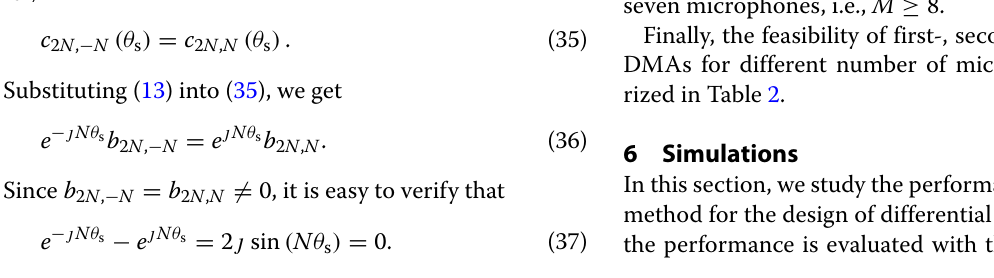
Table 2 Feasibility of the first-, second-, and third-order DMAs for different number of microphones, where “ blank represents infeasible First-order Second-order Third-order